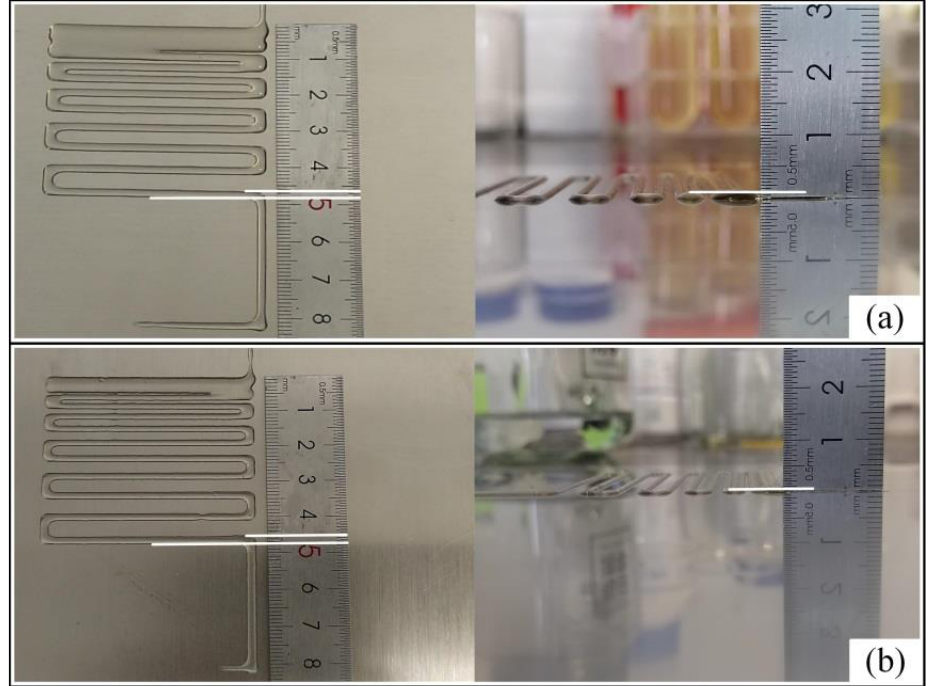
Figure 4. Two groups of gradient lines printed at different concentrations and temperatures. Comparison between the width and height of the gradient line filaments printed from gelatin/alginate/temperature (8 – 8 wt – 55 °C) mixed hydrogel and gelatin/alginate/temperature (7 – 7 wt% – 65 °C) mixed hydrogel. The height and width of the gradient lines were clearly different between the two groups. ( a ) The contact angle of the hybrid hydrogel was 76°, the width of the printing filament was about 2 mm, and the height was about 0.4 mm. ( b ) The contact angle of the mixed hydrogel was 73.5°, the width of the printed filament was about 2.5 mm, and the height was about 0.2 mm. As the hydrogel contact angle decreased, the printed filaments gradually became wider, and the height gradually decreased. The thickness of the vessel wall changed with the temperature and solution concentra- tion. The wall thickness of the vessel was made easier to visualize by staining; the thicker the wall, the darker the color presented. As shown in Figure 5b,c, the external wall of the nine groups of blood vessels printed in this test was smooth, with a uniform shape and good elastic mechanical support performance. The 80 mm artificial blood vessel with a diameter of 8 mm can still be placed vertically on the surface of the glass plate after it is detached from the screw rod (Figure 5d). According to Figure 6, the relationship between the contact angle and the wall thick- wall thickness of the artificial blood vessel gradually became thicker. When the contact angle was 73.36 ◦ , the wall thickness of the printed vessel was 0.29 mm. When the contact angle was 76 ◦ , the wall thickness gradually increased with the increase of the contact angle, reaching 0.48 mm. It can be demonstrated that there is a clear relationship between the vessel wall thickness and the contact angle of spiral-printed manufactured artificial blood vessels. The experimental results confirmed that changing the contact angle of the material can effectively control the wall thickness of the vascular